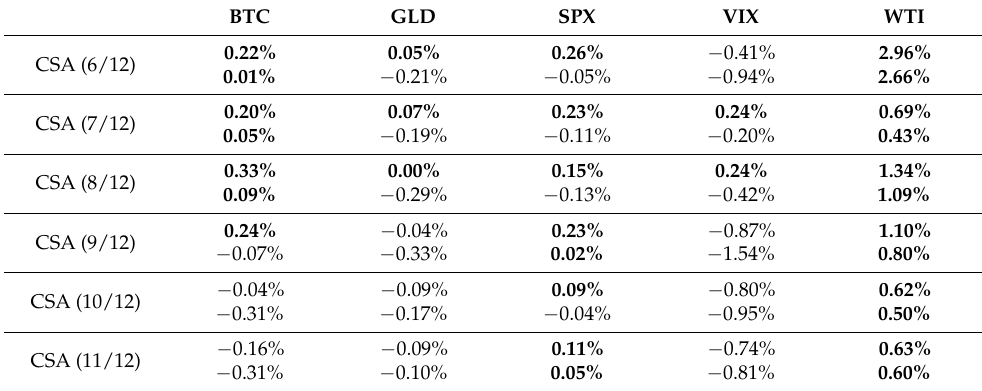
Table 3. CSA strategy profits across the entire sample